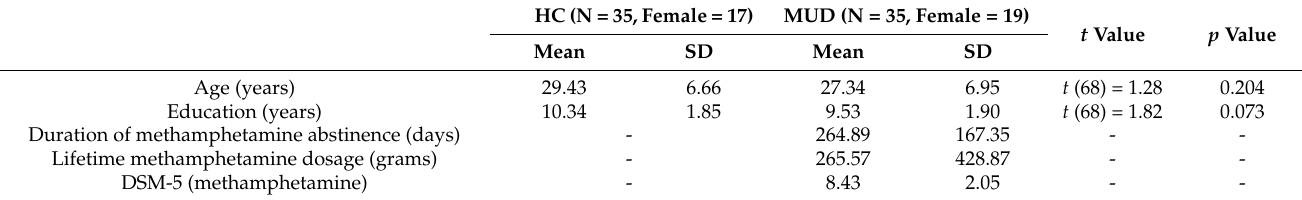
Table 1. Demographic characteristics of HCs and MUD